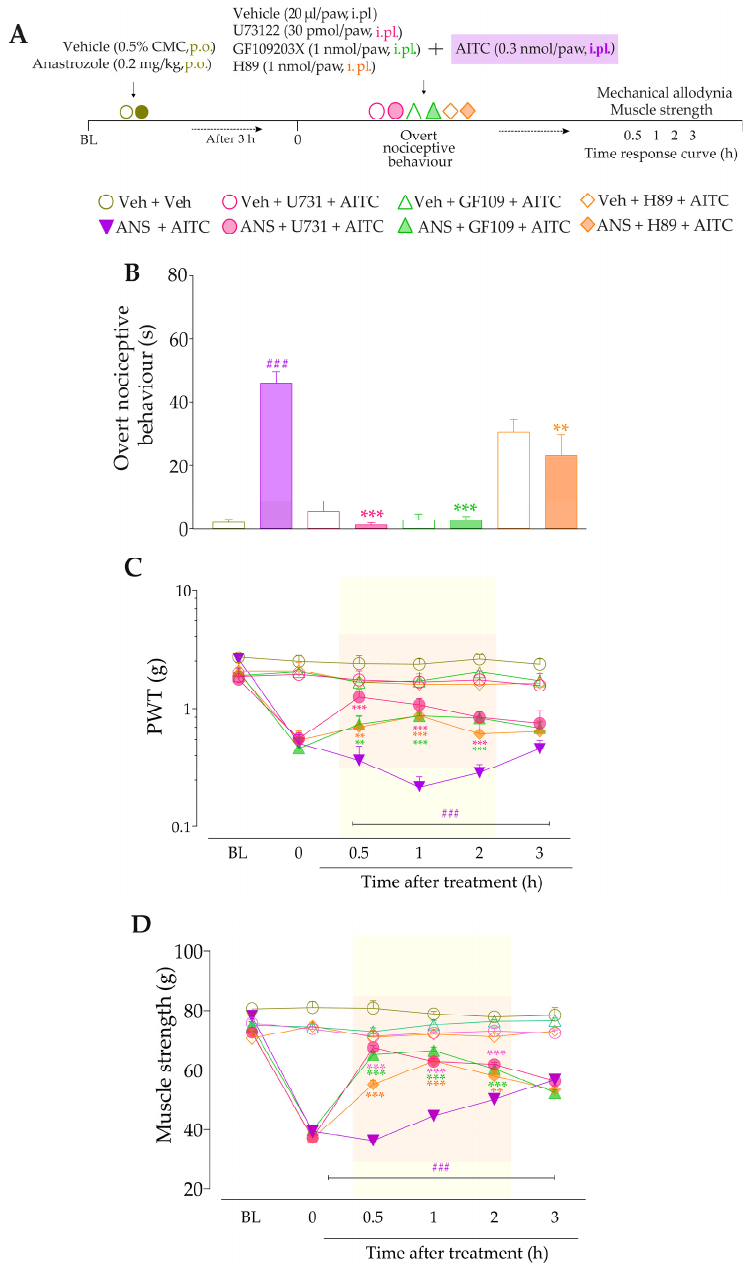
Figure 8. PLC/PKC and PKA signaling pathway inhibition a tt enuated the nociceptive behaviors induced by the TRPA1 agonist in anastrozole-treated mice. ( A ) Male C57BL/6 mice were treated by the oral route (p.o.) with anastrozole (0.2 mg/kg) or its vehicle (0.5% CMC) to induce painful behaviors. At 3 h after anastrozole administration (Time 0), the animals received the intraplantar (i.pl.) co-